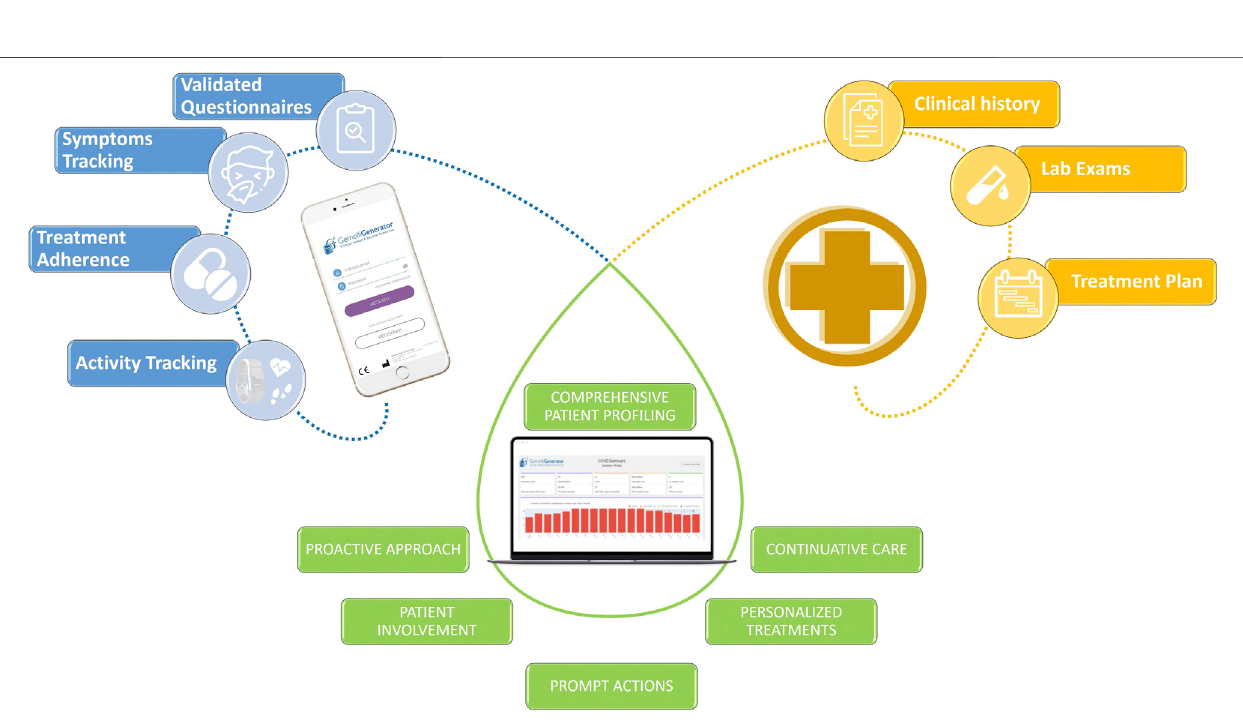
Frontiers in Computer Science |